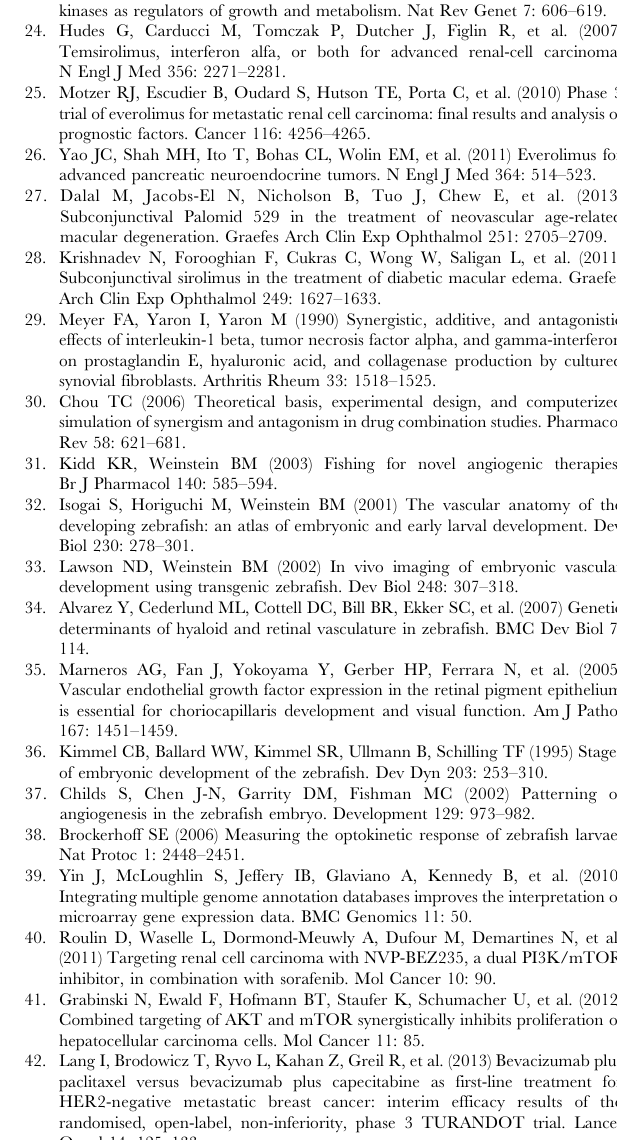
or 5 m M A66 + WYE-125132 appear to have antagonist effects in the HV assay. Data are means 6 s.e.m ( n = 24–30). *P , 0.05, **P , 0.01 & ***P , 0.001. (TIF) Figure S2 PI3K/Akt/mTOR inhibitors attenuate p70S6k and Akt activity in zebrafish larvae. Representative Western blot ( A–B ) and densitometric analysis ( C–D ) of extracts from whole larvae treated from 2–5 dpf with 5 m M NVP-BEZ235, 5 m M PI-103, 5 m M LY294002, 5 m M Rapamycin, 2.5 m M NVP- BEZ235 + PI-103, 2.5 m M LY294002 + NVP-BEZ235 and 2.5 m M NVP-BEZ235 + Rapamycin or DMSO. The vast majority of individual and combination drugs significantly reduced the levels of the downstream target p-p70S6k (Thr389) with only modest or no reductions in the levels of p-Akt (Thr308) which is further upstream. Bar graphs show mean band density normalized relative to p-p70S6k/p70S6k ratio or p-Akt/Akt ratio. Data are